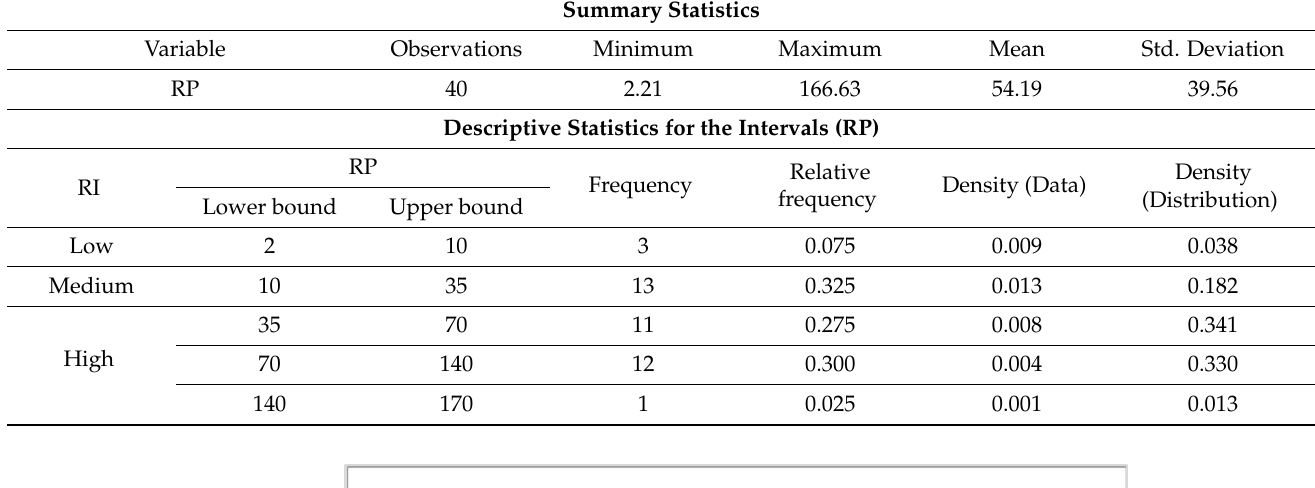
Table 5. Summary of the results of radon potential categorisation based on the Neznal method. Summary Statistics